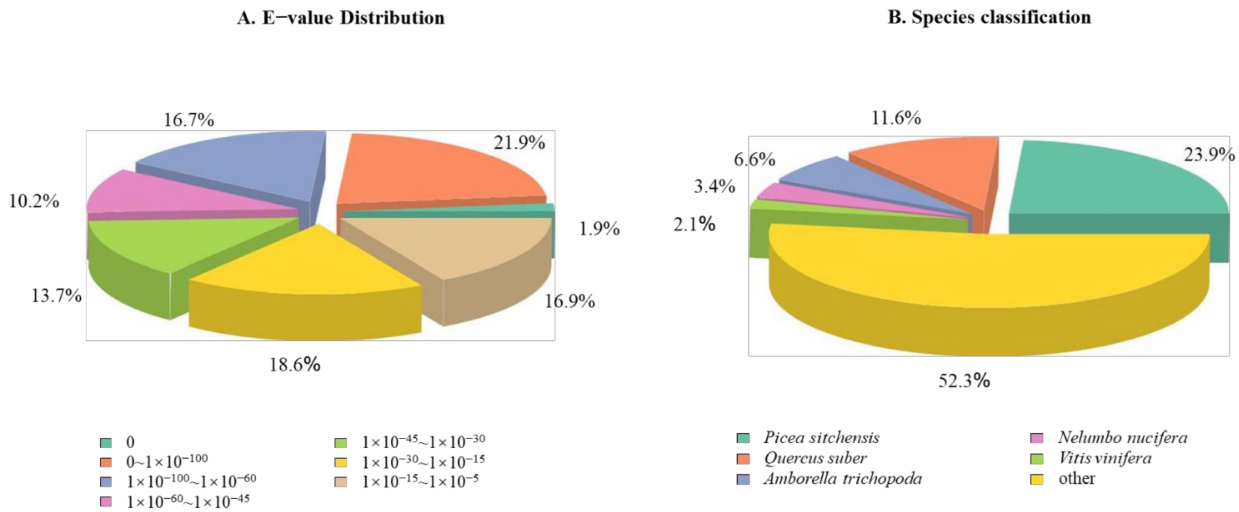
Figure 5. Distribution of E-values ( A ) and species classification ( B ) of D. pectinatum unigenes when aligned in the NCBI non-redundant protein